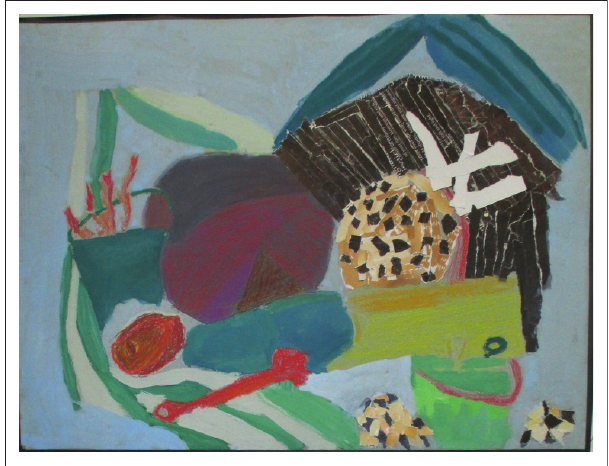
FIGURE 2: Sea-things, mixed media picture.